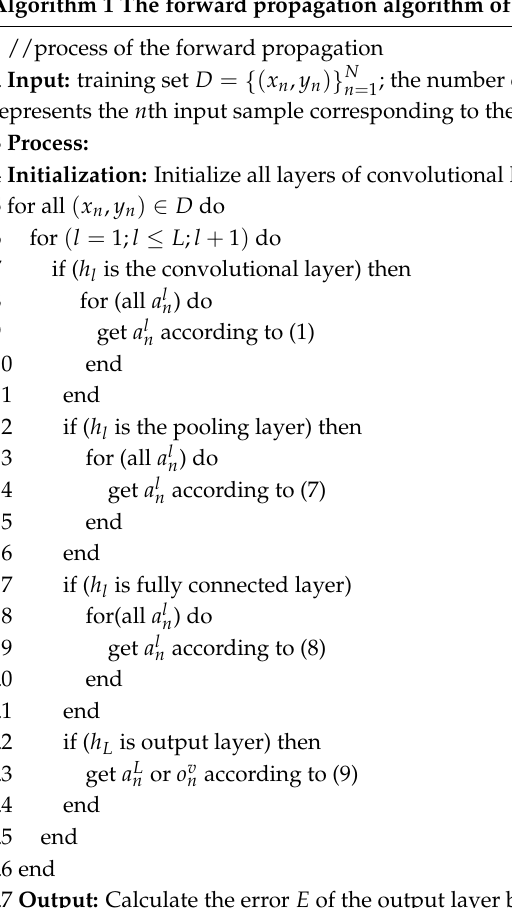
Algorithm 1 The forward propagation algorithm of